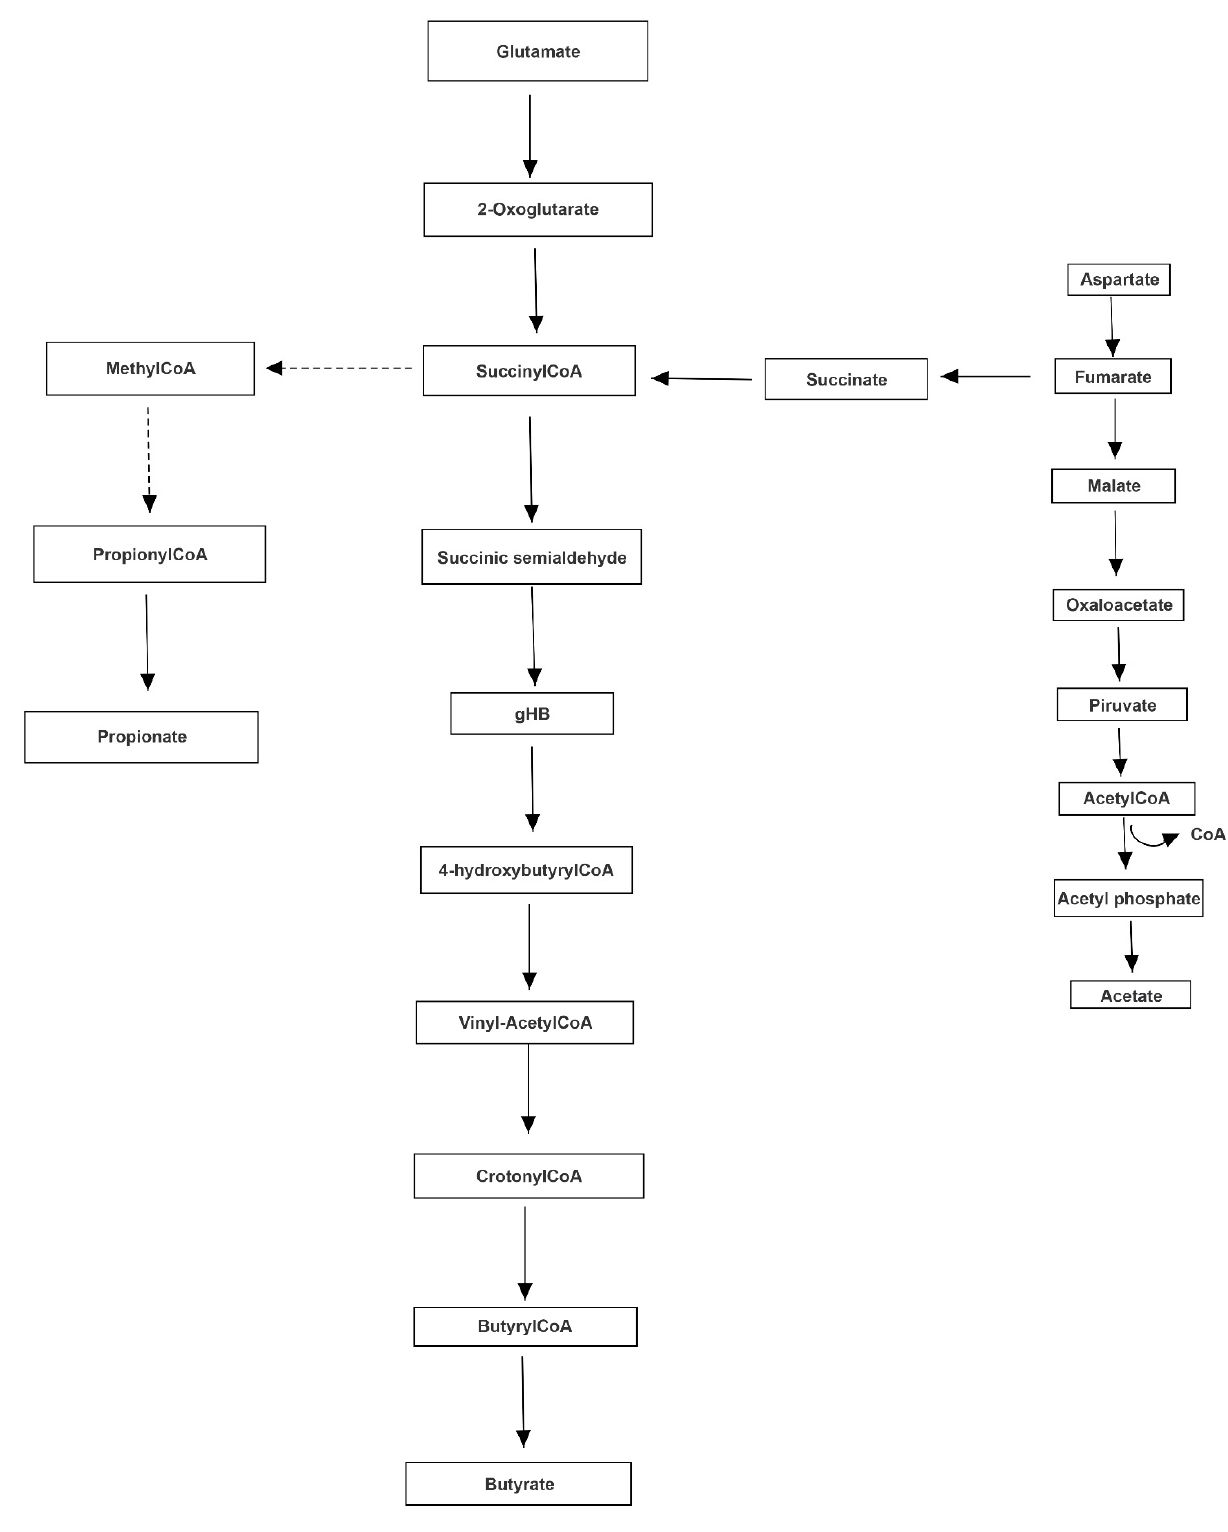
Figure 1. Mixed acid fermentation involving microbiota bacteria. The metabolic way of mixed acid fermentation could produce short chain fatty acids, able to determine an excess of serotonin.